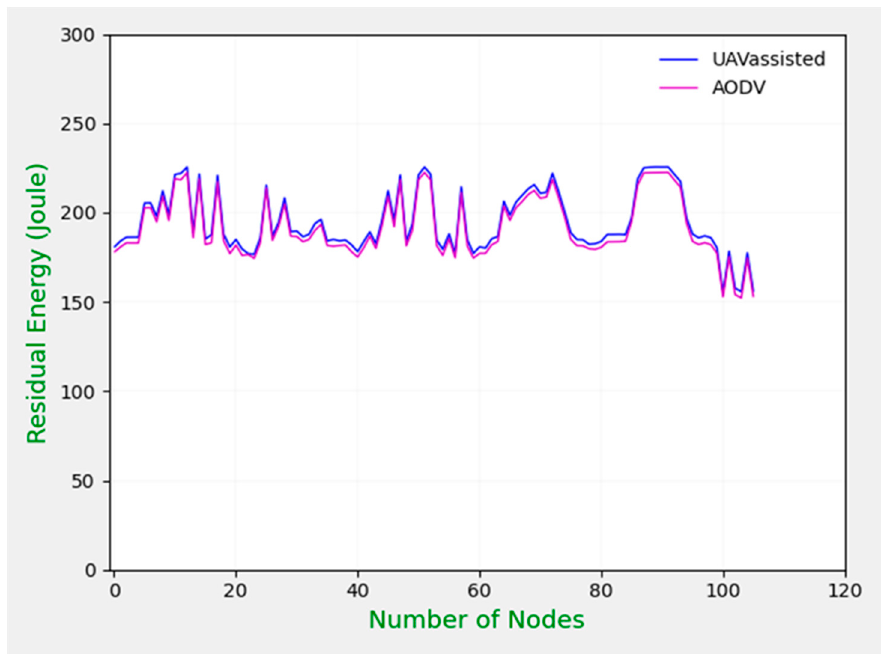
Figure 8. Residual energy.